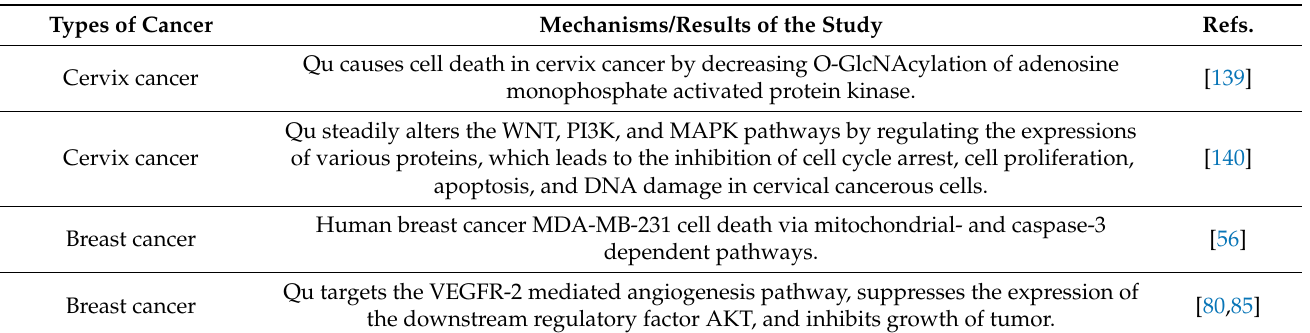
promotion, and progression.